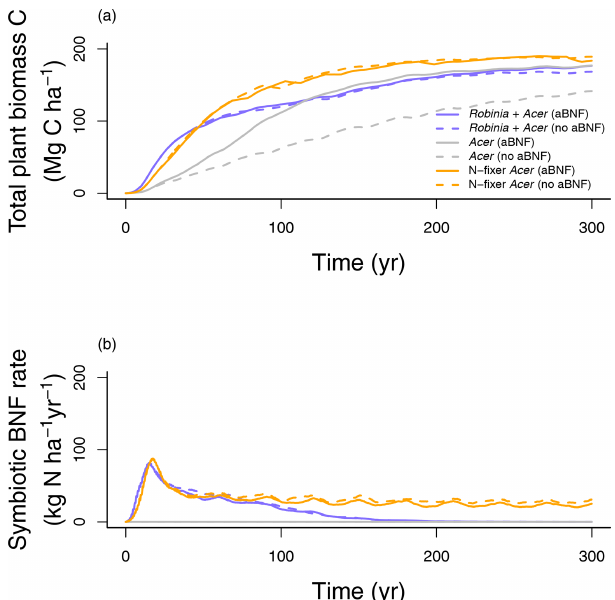
Figure 10. Simulated (a) total plant biomass C and (b) symbiotic BNF rate over time from LM4.1-BNF initialized with both Robinia and Acer , only Acer , and only N-fixer Acer , with and without asym- biotic BNF. aBNF indicates asymbiotic